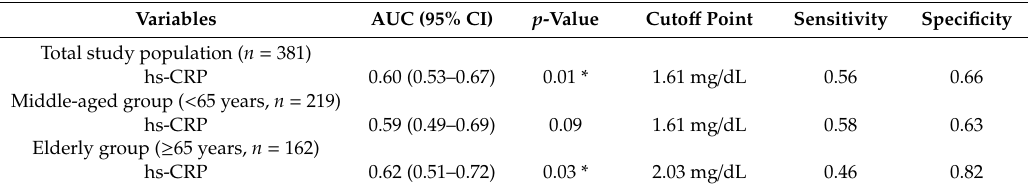
Figure 3. The receiver operating characteristic curves for high-sensitivity C-reactive protein as a predictor of renal impairment in the total group ( a ), middle-aged group ( b ), and elderly group ( c ). Table 4. Predictive values of hs-CRP for renal impairment in the total, middle-aged, and elderly